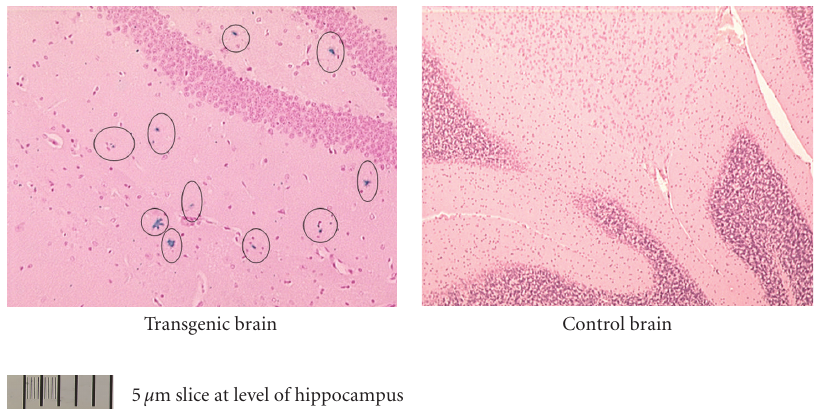
Figure 9: 15 mo AD Transgenic: hippocampal staining of Fe 2+ .